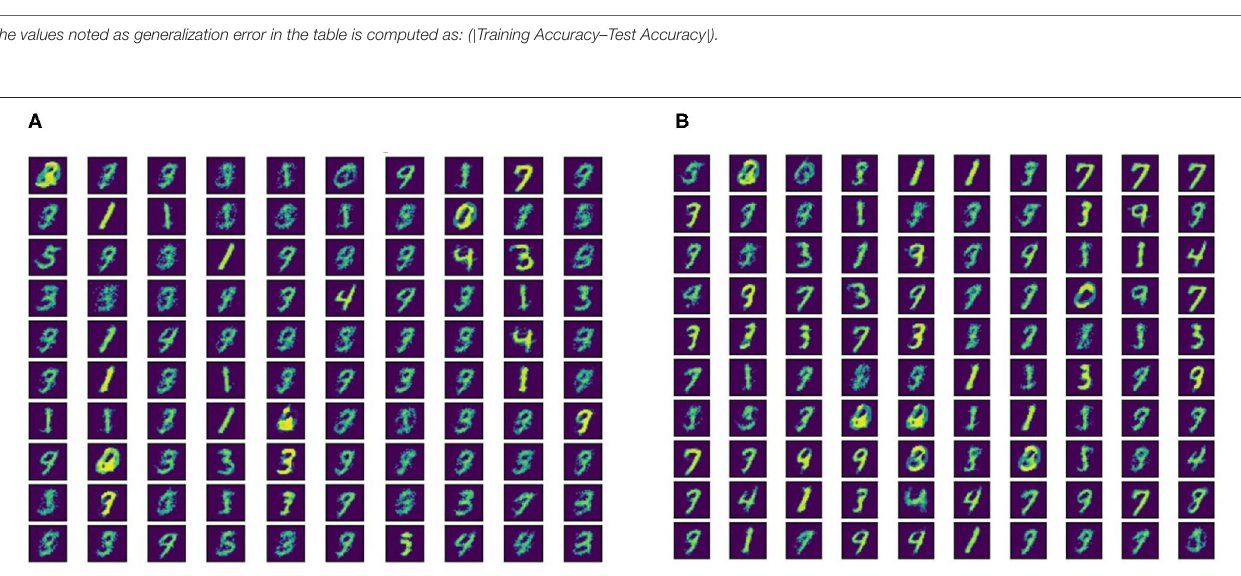
TABLE 3 | The impact of learning rate on the generalization error.